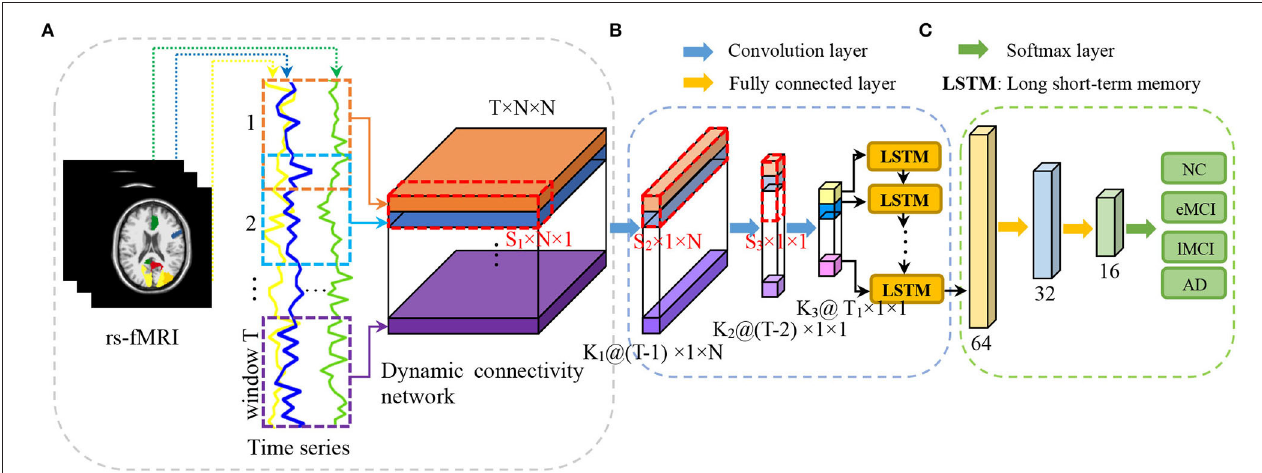
FIGURE 1 | Illustration of the proposed convolutional recurrent neural network (CRNN) for brain disease classification with rs-fMRI data, consisting of (A) image preprocessing and dynamic functional connectivity network construction, (B) temporal and sequential features extraction via three convolutional layers and a long short-term memory (LSTM) layer, and (C) classification via three fully connected